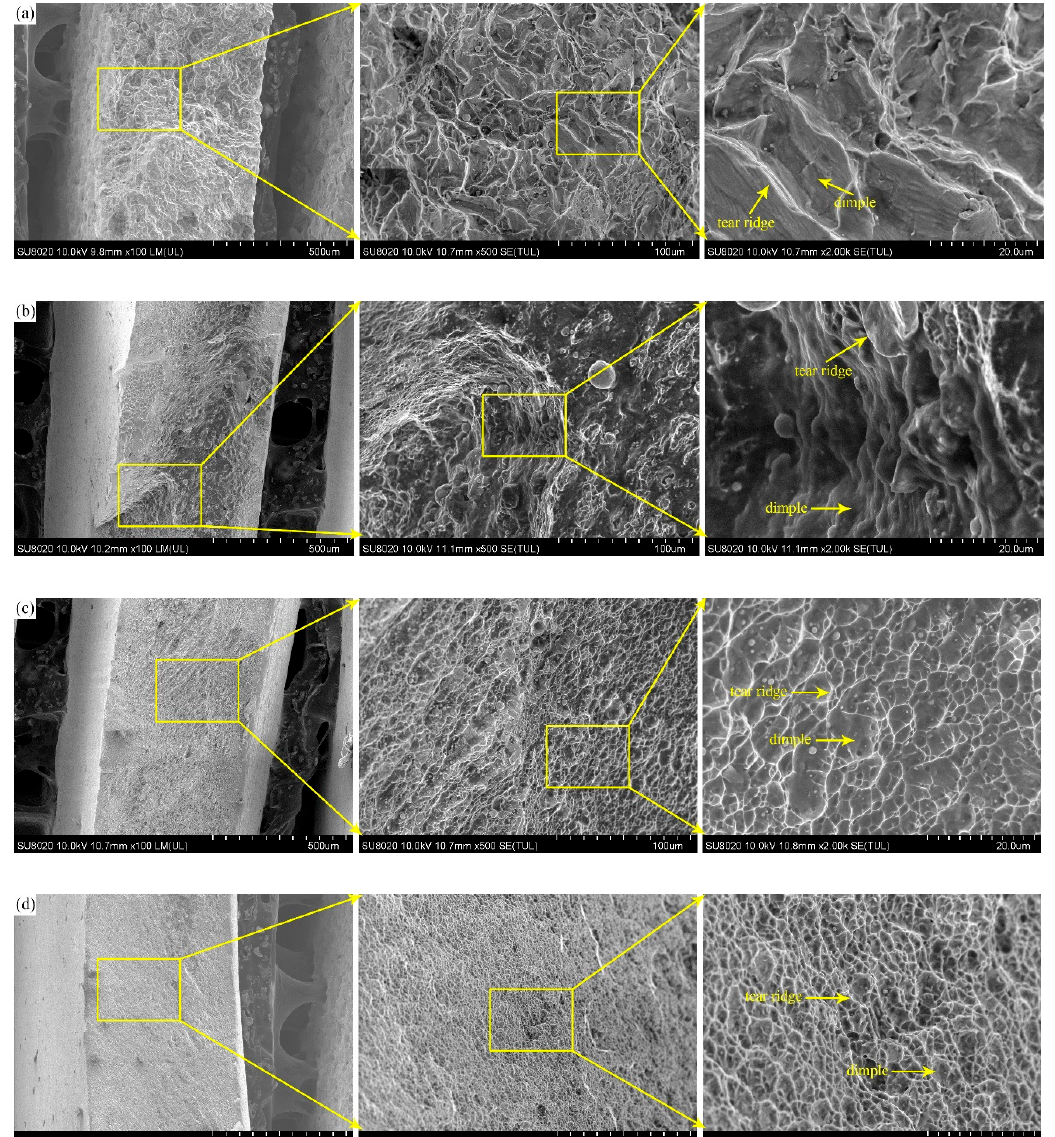
Figure 10. The tensile fracture area of CP Ti with ( a ) as-recevied, ( b ) 1 cycle of MDF, ( c ) 2 cycles of MDF, ( d ) 3 cycles of MDF.